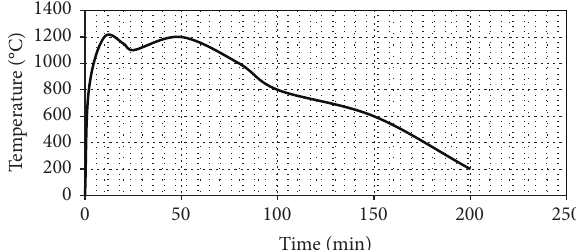
Figure 2: The temperature rise curve of tunnel fire (RABT